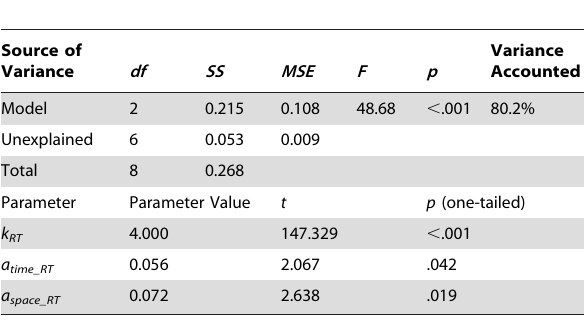
Table 2. Regression results from the least-squares fit of Eq. 3 to the RT entropy